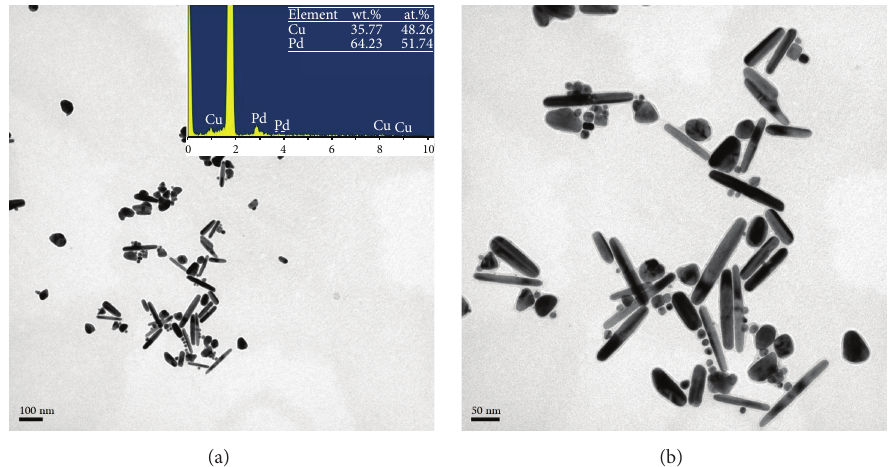
Figure 3: (a, b) Typical TEM images of Pd-Cu nanorods with different magnifications. The inset in (a) is the corresponding EDS